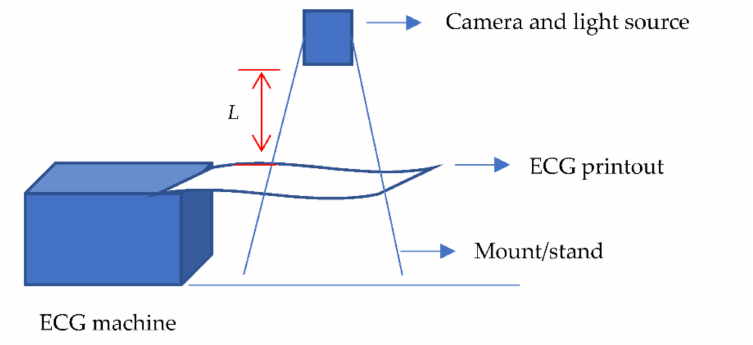
Figure 18. Illustration of possible hardware setup for investigating standard image capture with predetermined L distance from the ECG printout to the